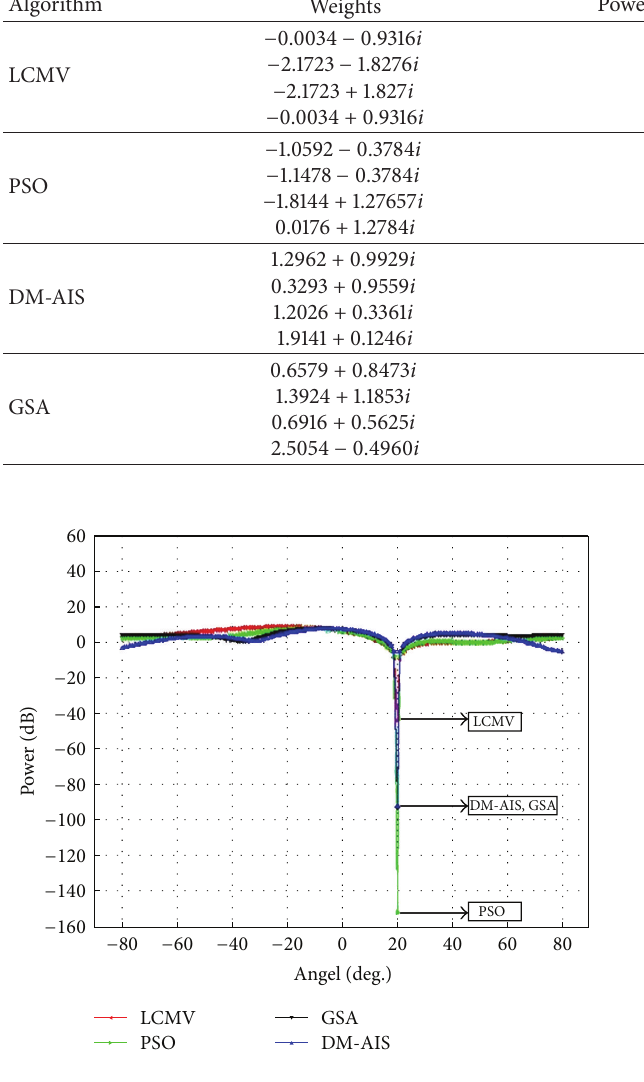
Figure 1: Comparison of performance of power response LCMV, PSO-LCMV, DM-AIS-LCMV, and GSA-LCMV for user at 0 ∘ with interference at 20 ∘ by using 4 elements.